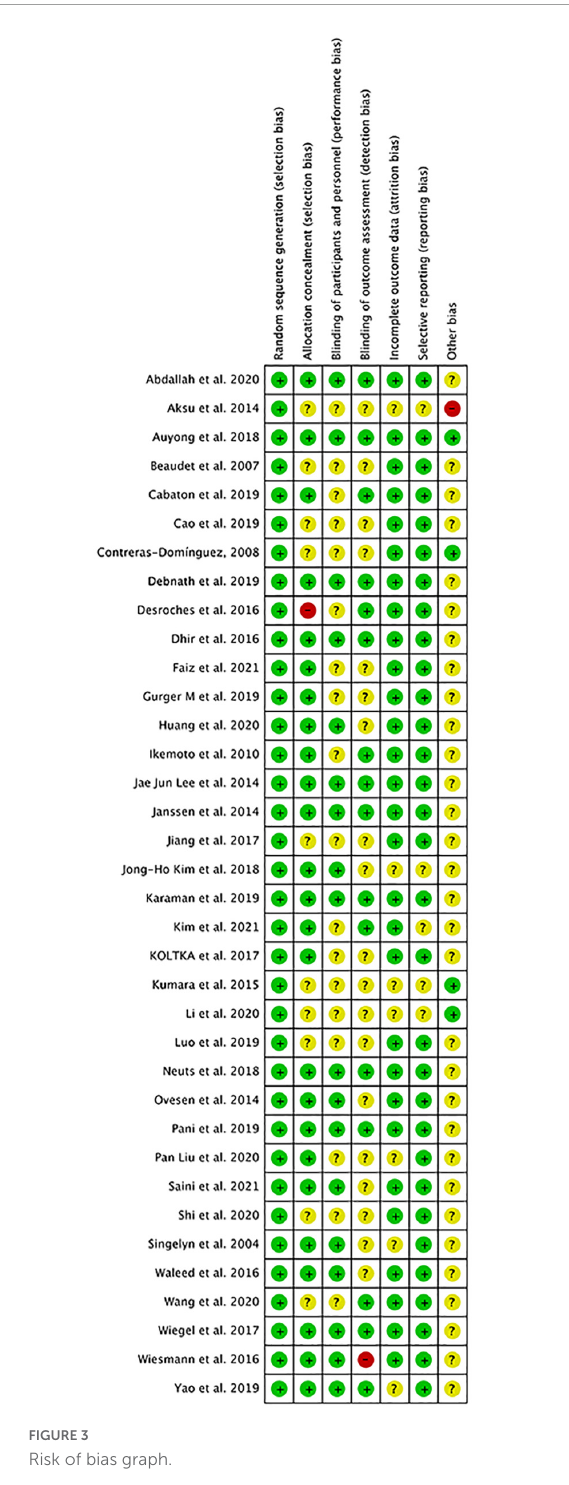
FIGURE3 Risk of bias